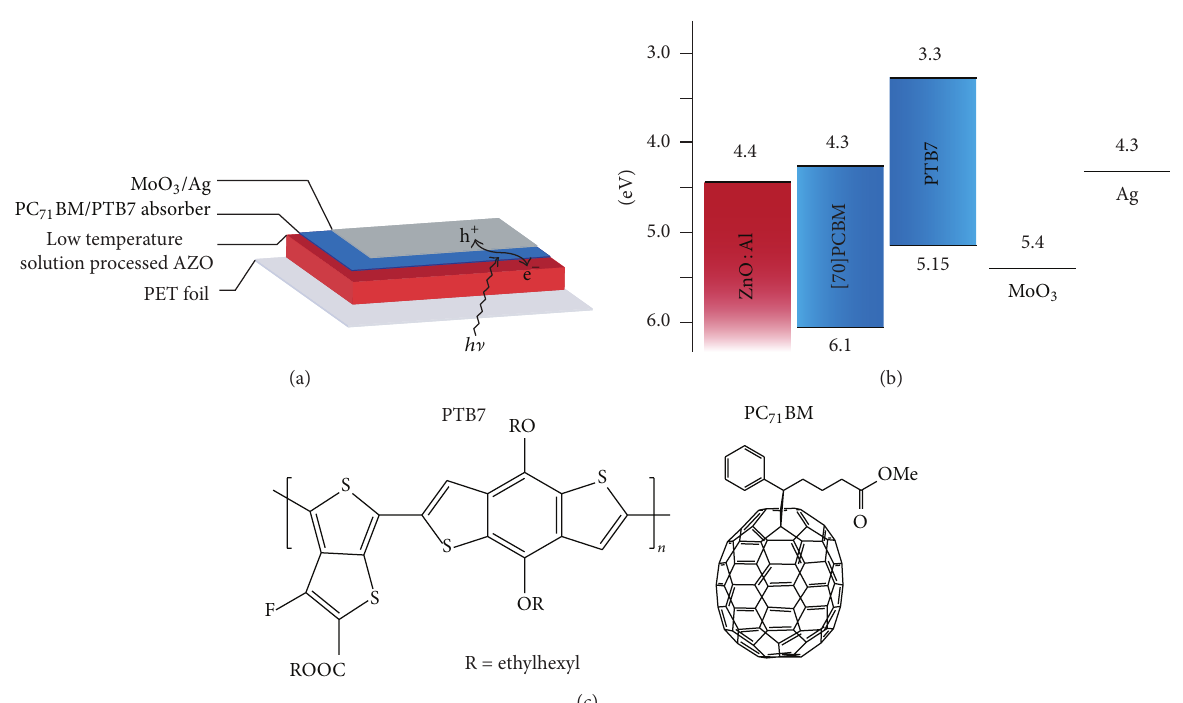
Figure 1: (a) Schematic view of the device architecture. (b) Vacuum energy level diagram for each material used in this study. (c) Chemical structure of the polymer donor PTB7 and the fullerene-derivative PC 71